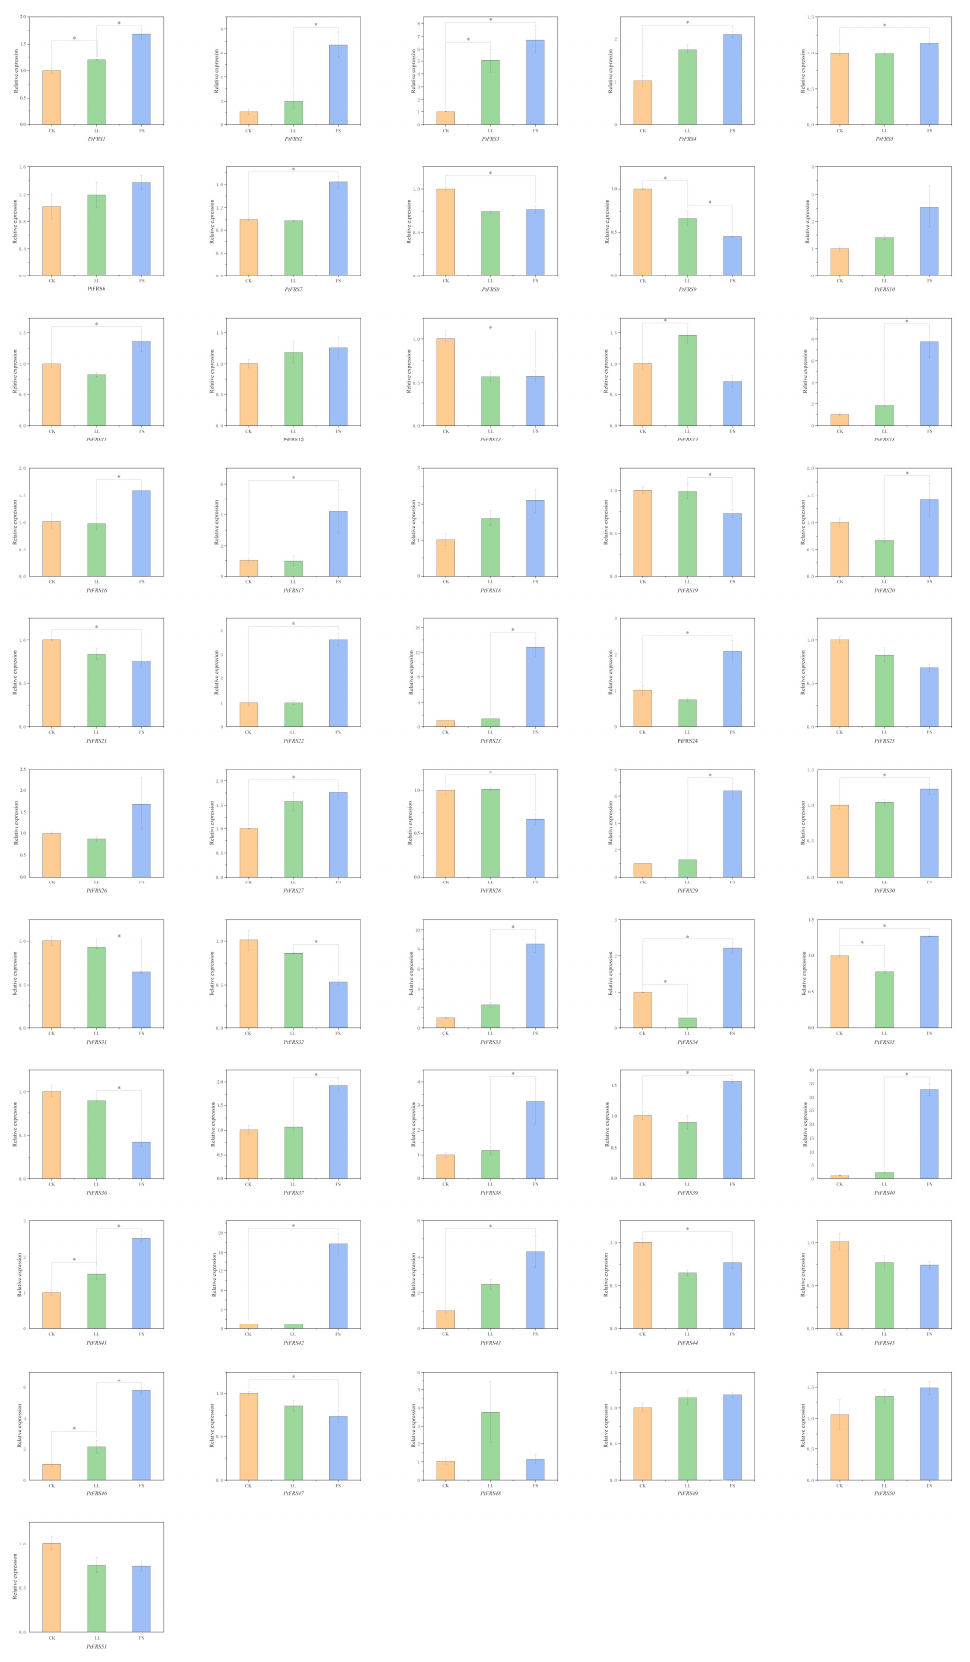
Figure 6. Expression patterns of PtrFRSs in response to changes in light intensity. CK normal light, LL low light, FS full shade. Average data with standard errors from three replicates is presented (* p <